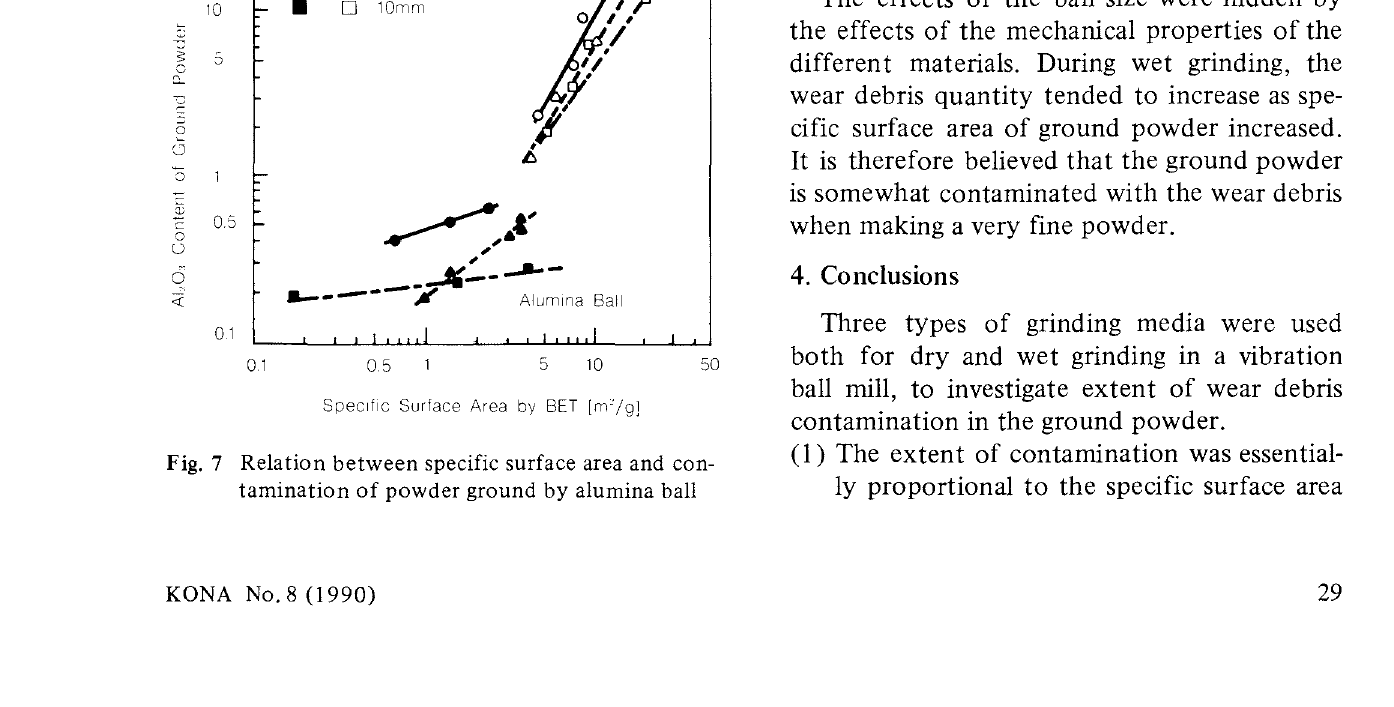
Fig. 7 Relation between specific surface area and con tamination of powder ground by alumina ball